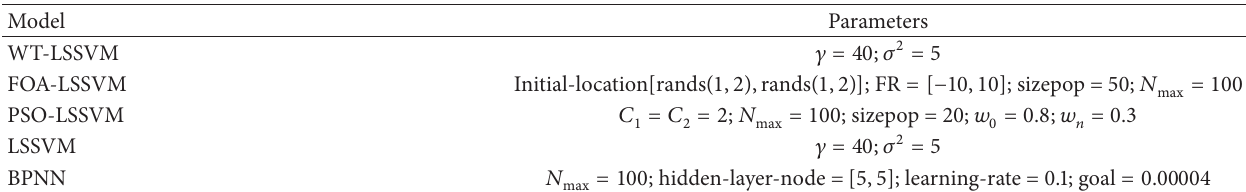
Table 2: Parameters of models mentioned in the